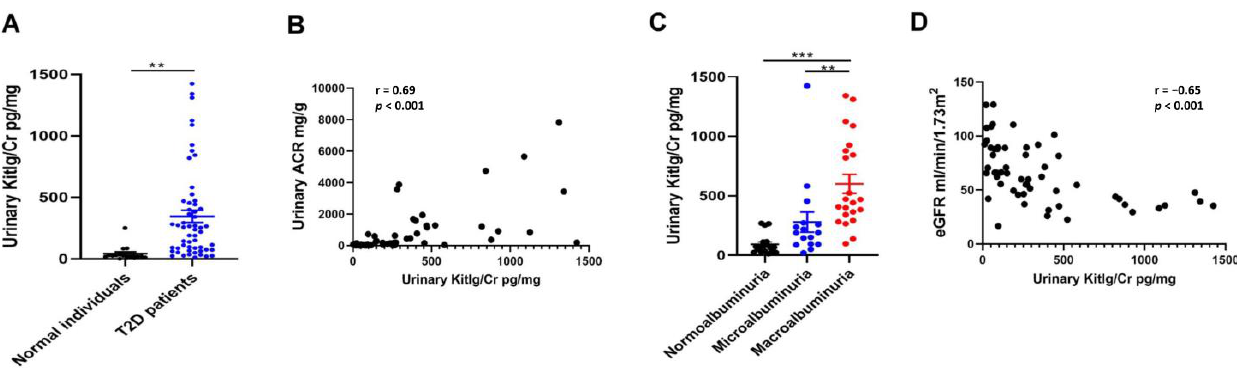
Figure 6. Positive relationship between urinary KITLG levels and kidney dysfunction in humans.